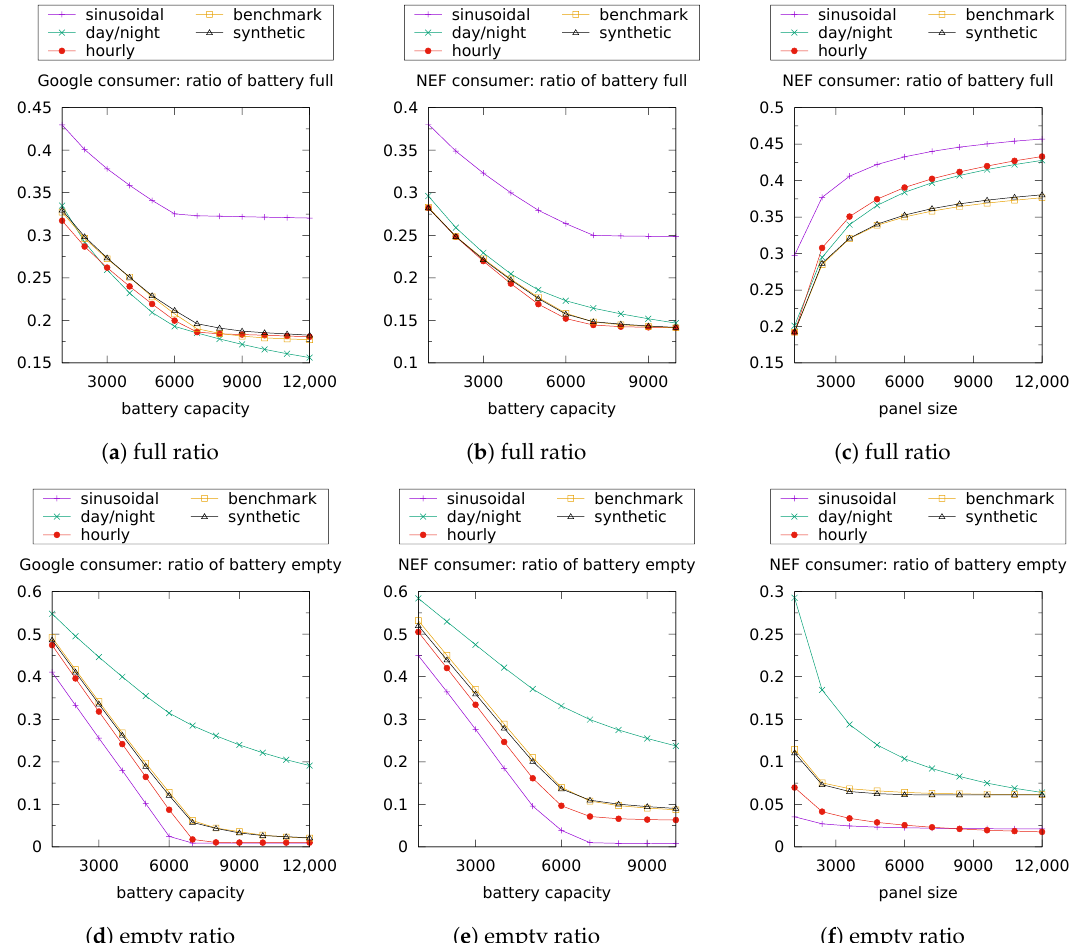
Figure 17. Experiments for Golden: full ratio ( a – c ) and empty ratio ( d – f ) as the battery capacity varies (( a , b , d , e ) panel surface 1200 m 2 ) and as the panel surface varies (( c , f ) battery capacity 6000 MJ).